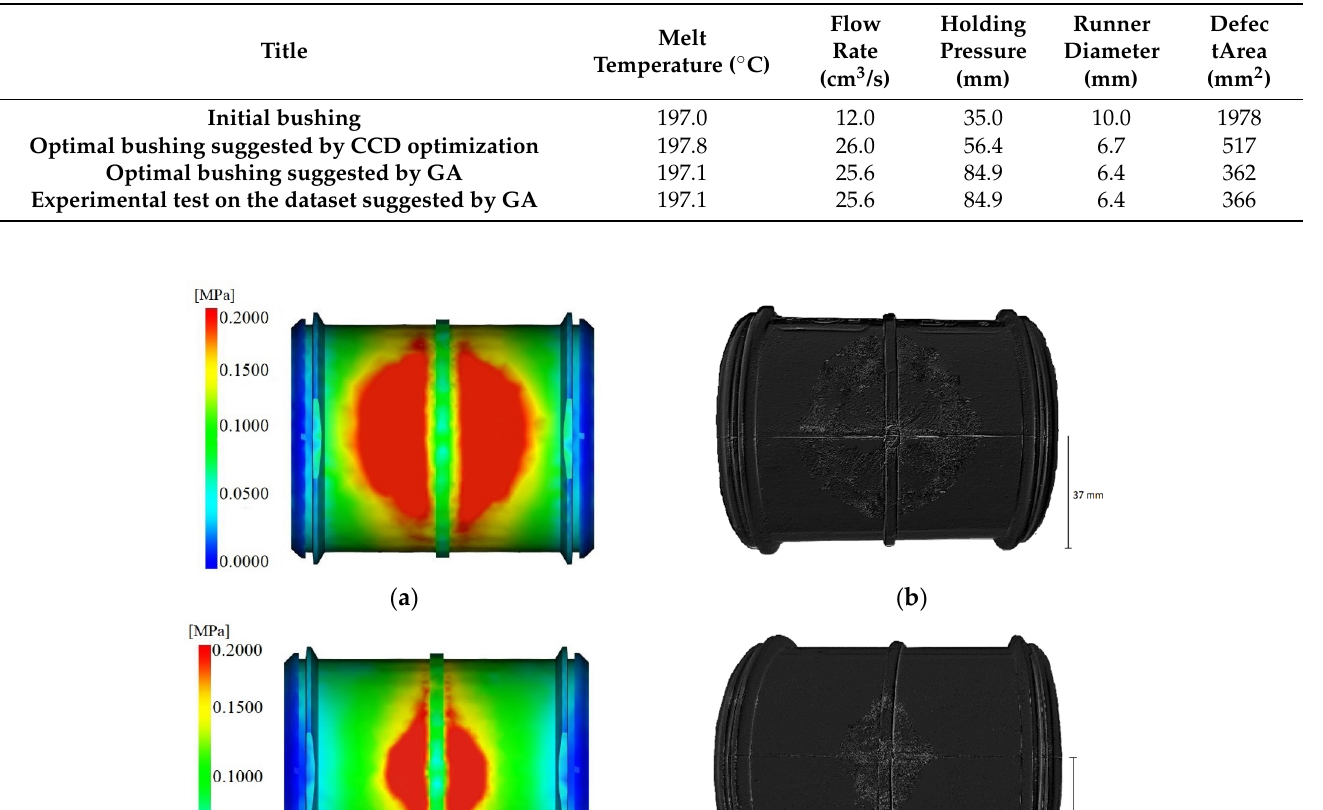
Table 9. Comparison of the defect area before and after optimization.